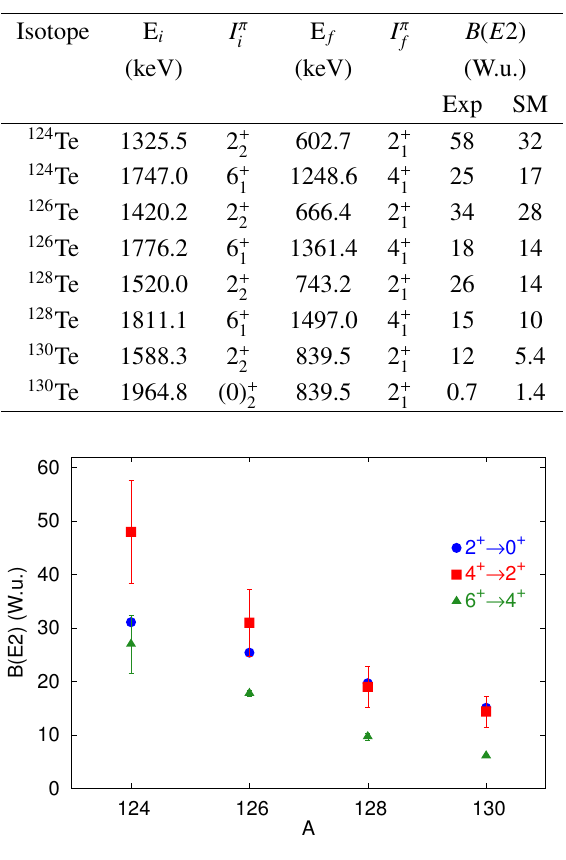
Figure 3. Systematics of measured B ( E 2) values across the Te isotopes. Data from this work and Nuclear Data Sheets